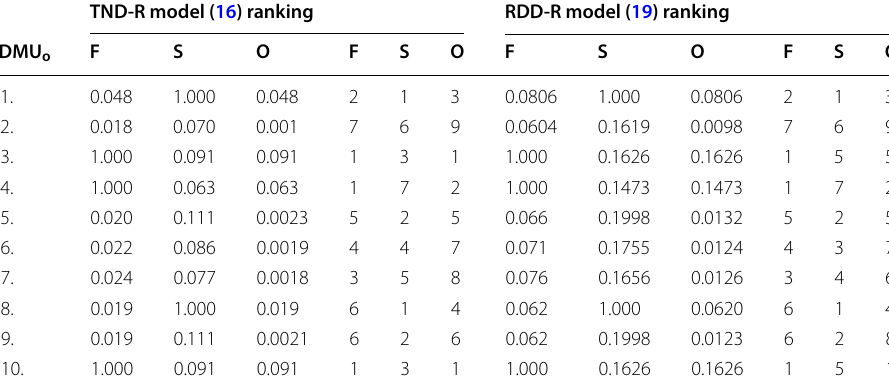
Table 4 Example 2. Results from RDD-R model (19) and TND-R model (16) TND‑R model (16)